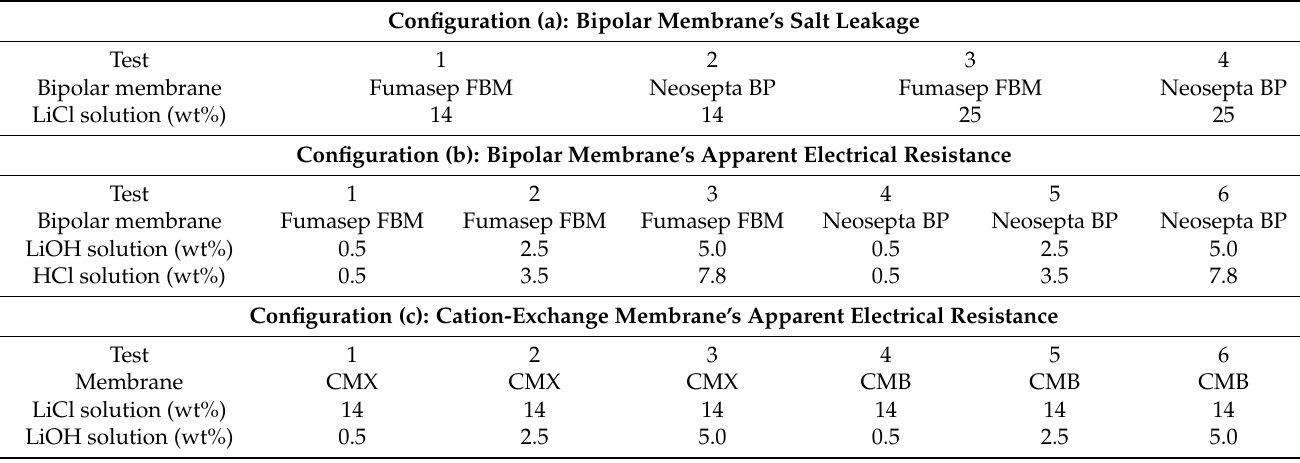
Table 4. Solution concentrations and membranes used in LSV